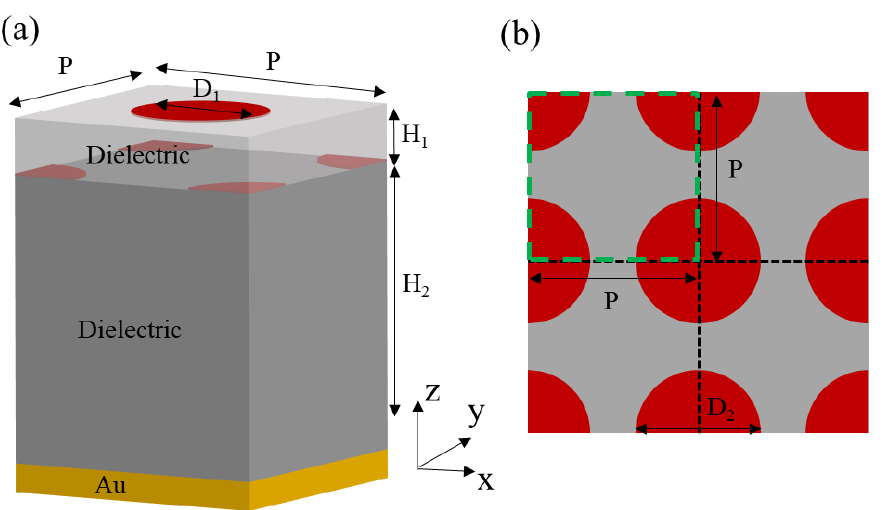
Figure 1. ( a ) Sketch of the proposed graphene-based absorber. ( b ) Top view of lower graphene nanodisk arrays.